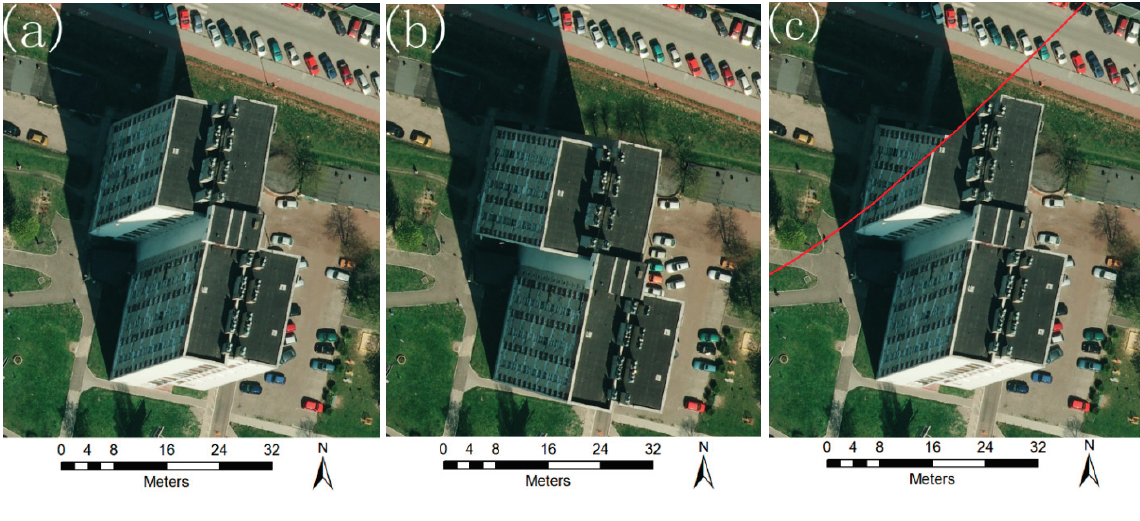
Figure 1. Visual discontinuity caused by relief displacement. ( a ) A building is provided in a digital orthophoto map (DOM); ( b ) the same building is provided in another DOM, where the original image is captured from a different angle; ( c ) the building is provided in the mosaicked image of two overlapping images, where the red line indicates the randomly selected